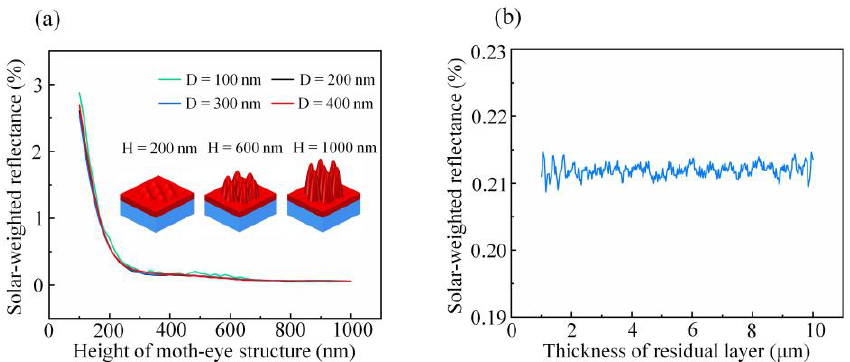
Figure 4. The solar-weighted reflectance for different parameters of ( a ) the height of moth-eye structure and ( b ) the residual layer thickness of NOA63 polymer.